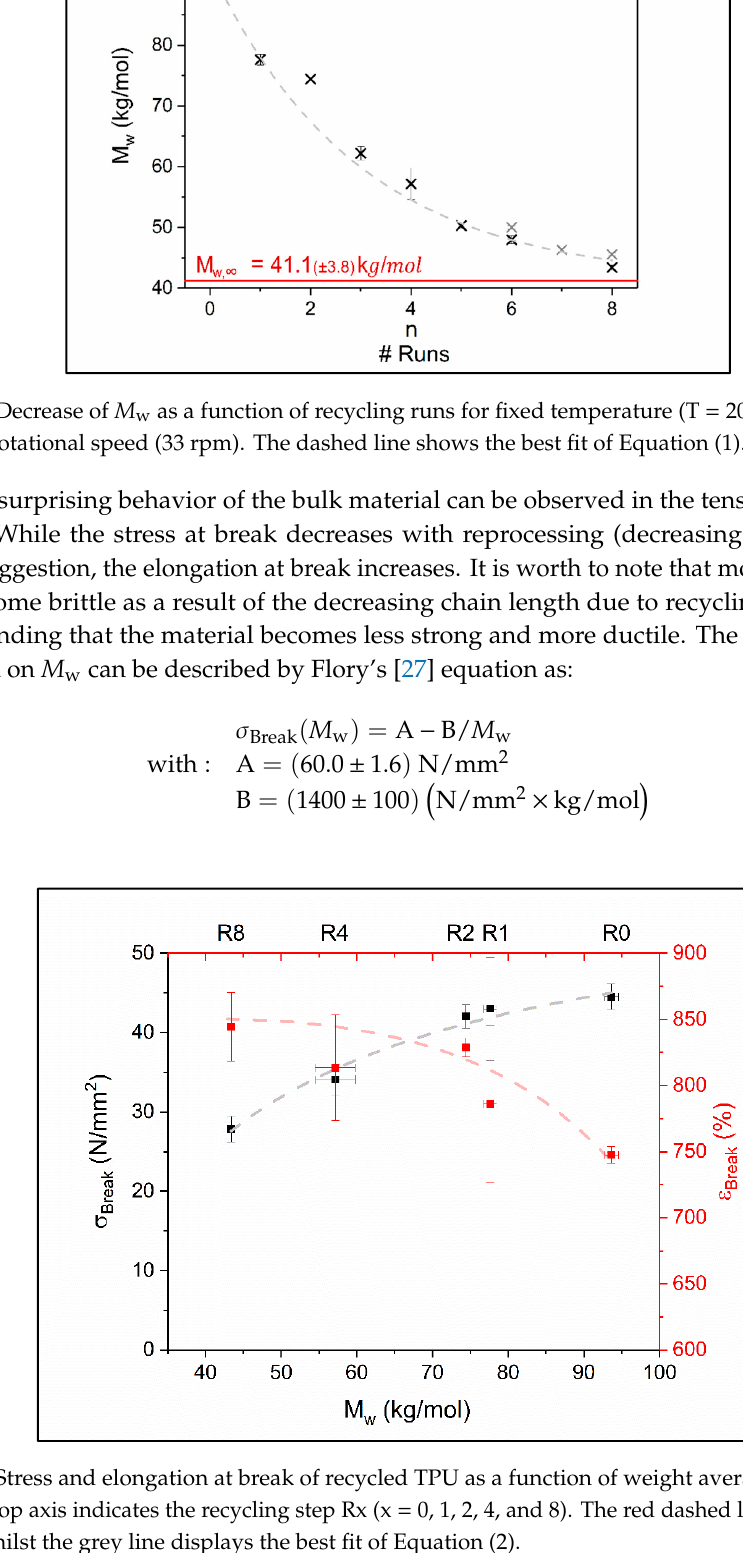
Figure 3. Decrease of M w as a function of recycling runs for fixed temperature (T = 205 °C) and fixed extruder rotational speed (33 rpm). The dashed line shows the best fit of Equation (1).